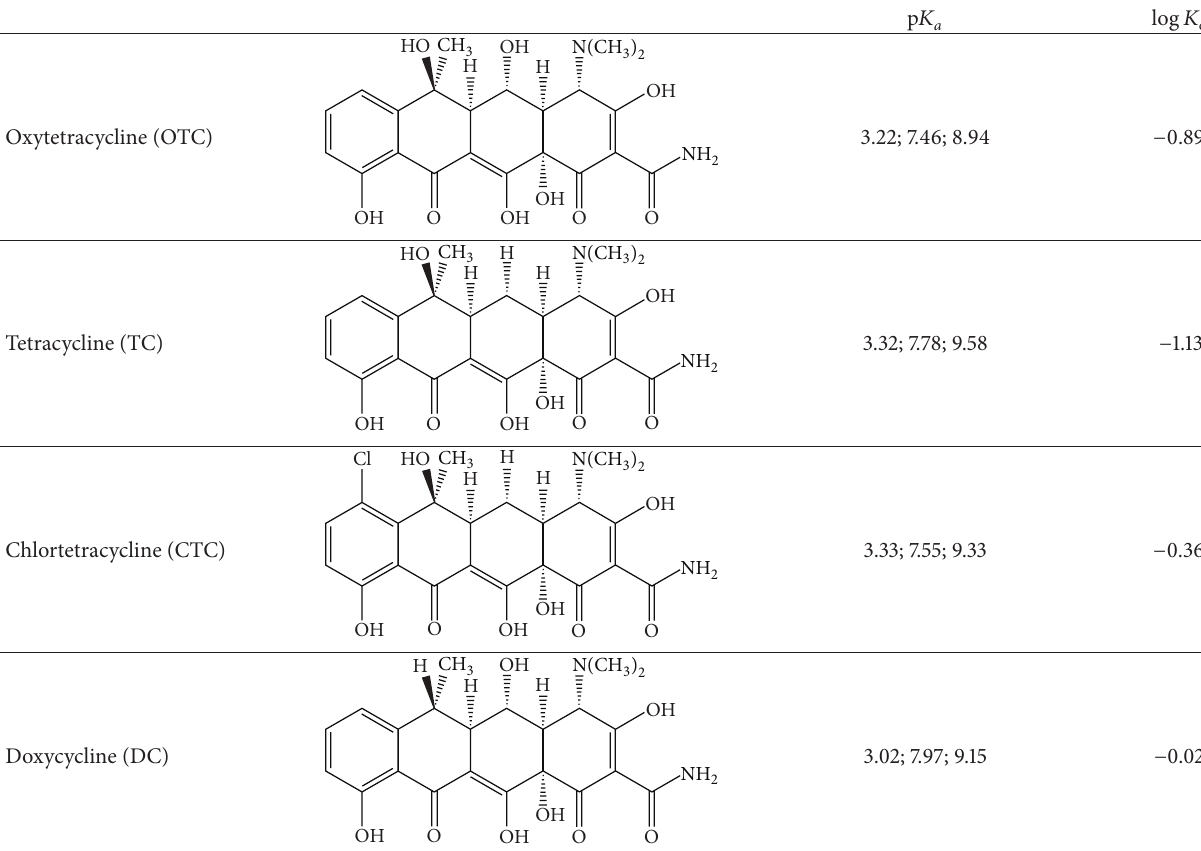
Table 1: Hydrophobicity, p 𝐾 𝑎 values, and structures of four